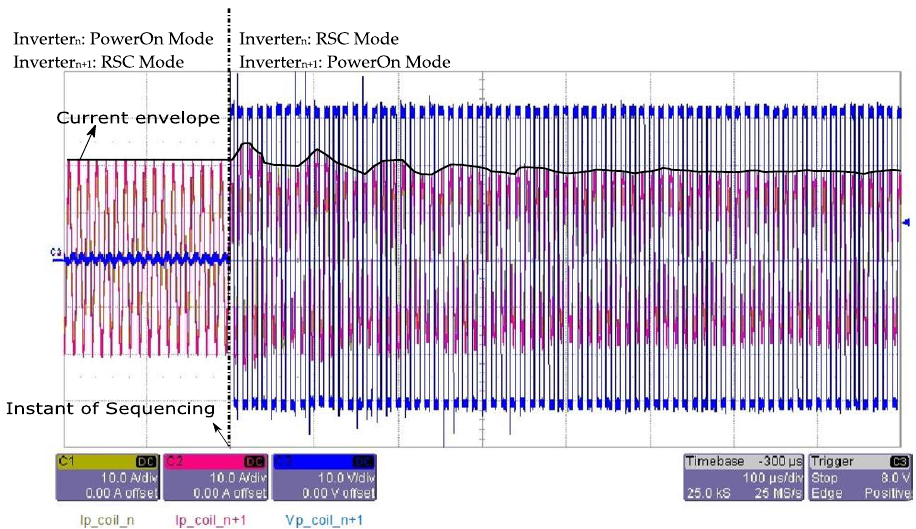
Figure 17. Voltage & Current measurements across the output of inverter n and inverter n+1 during the transient phase from coil n to coil n+1 .